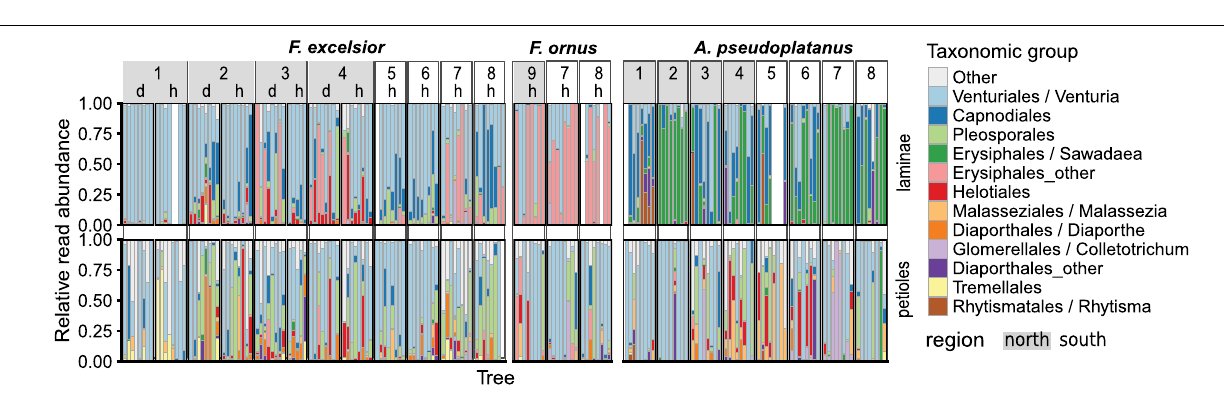
different leaf tissues, as examined using unconstrained